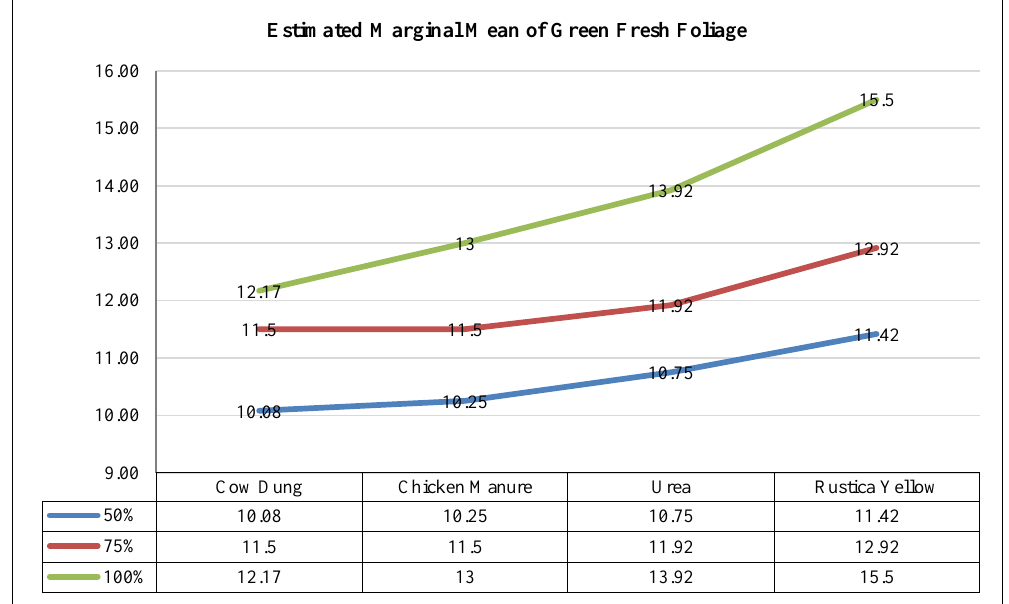
Estimated Marginal Mean of Green Fresh